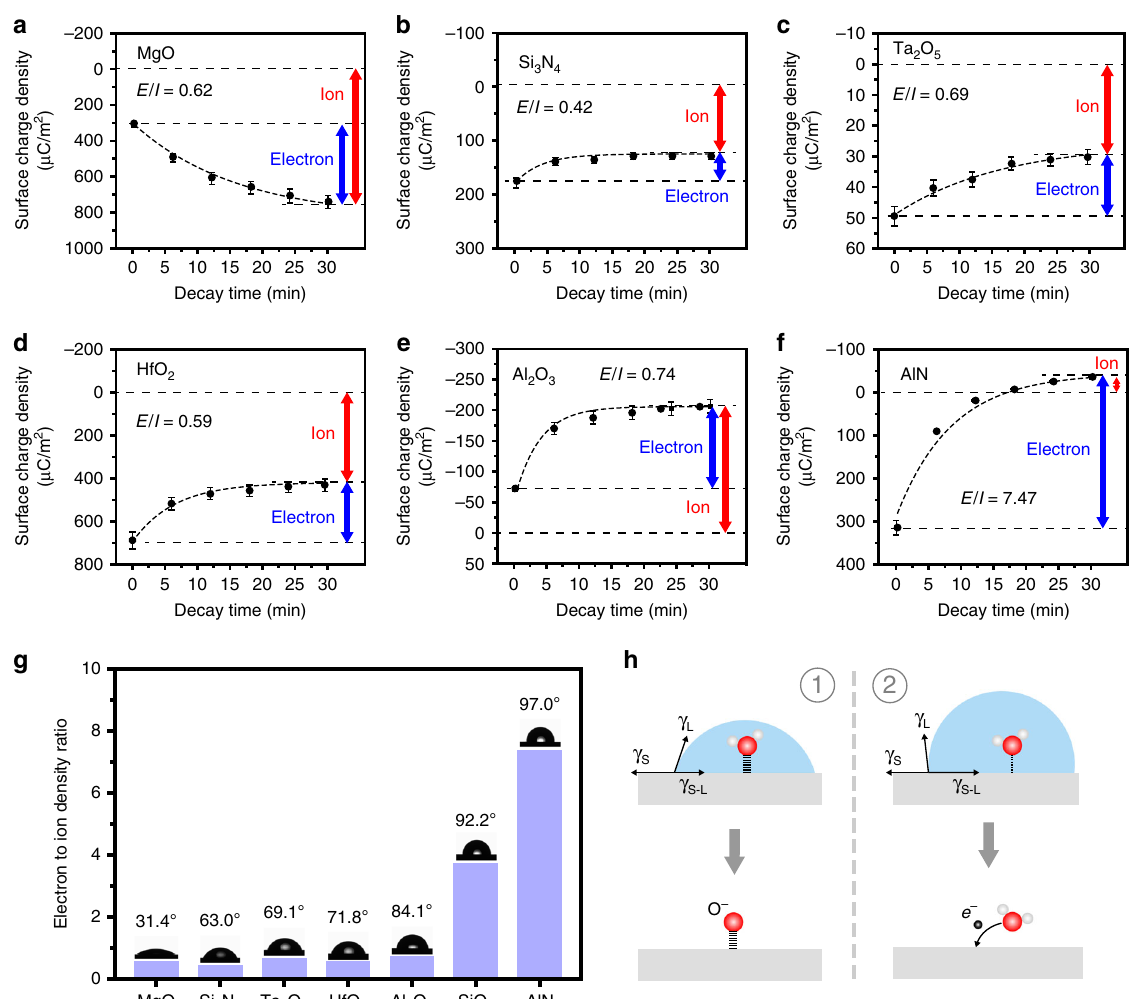
Fig. 3 Temperature effect on the CE between the DI water and the solids. The decay of CE charges (induced by contacting with the DI water at room temperature) on a MgO, b Si 3 N 4 , c Ta 2 O 5 , d HfO 2 , e Al 2 O 3 , and f AlN surfaces at 433 K, and the amount of the electron transfer and the ion transfer in the CE between the DI water and different insulators. g The relation between the electron transfer to the ion transfer ratio and the DI water contact angle (WCA) of the materials. h The schematic of WCA effects on the ion transfer and electron transfer in liquid – solid CE. γ L , γ S , and γ L − S denote the liquid – gas interfacial tension, solid – gas interfacial tension and liquid – solid interfacial tension, respectively. (Error bar are de fi ned as s.